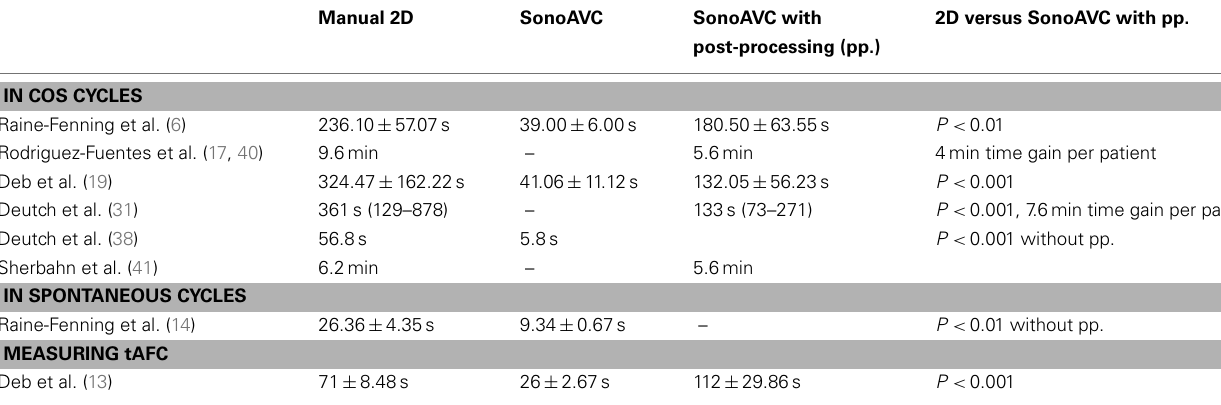
Table 2 | Evaluation of work flow .